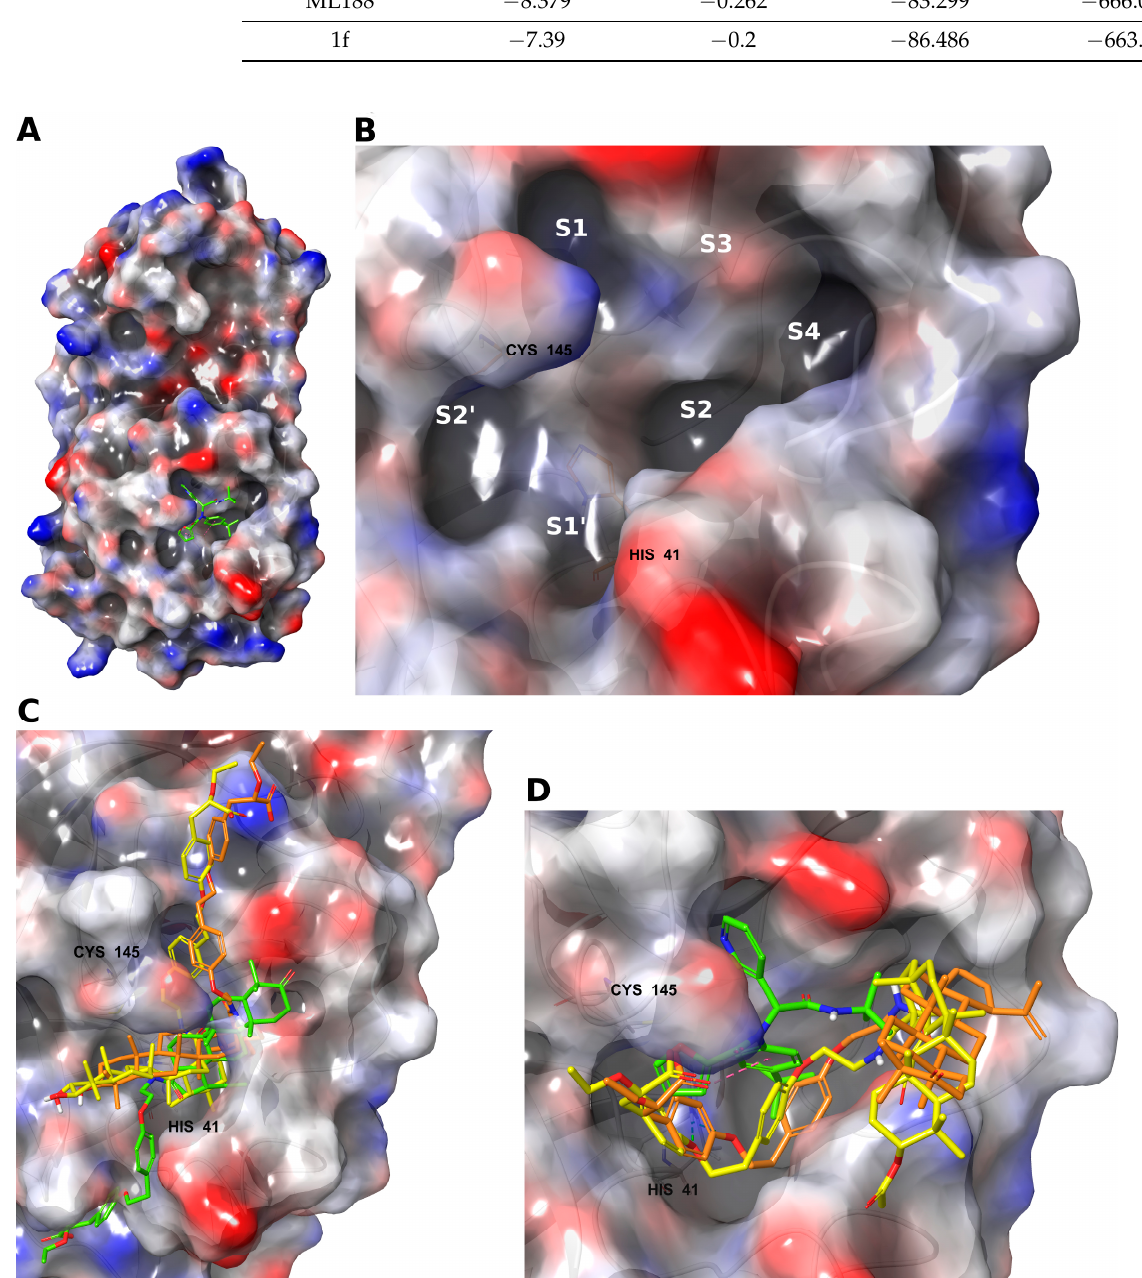
Figure 3. ( A ) The SARS-CoV-2 main protease subunit with an inhibitor at the active site. ( B ) Active site subpockets. The superpositions of compounds in the active site of the SARS-CoV-2 main protease show differences in their location with respect to the active site: ( C ) 1e (yellow), 1d (orange), and 1b (green); ( D ) 1c (yellow), 1a (orange), and ML188